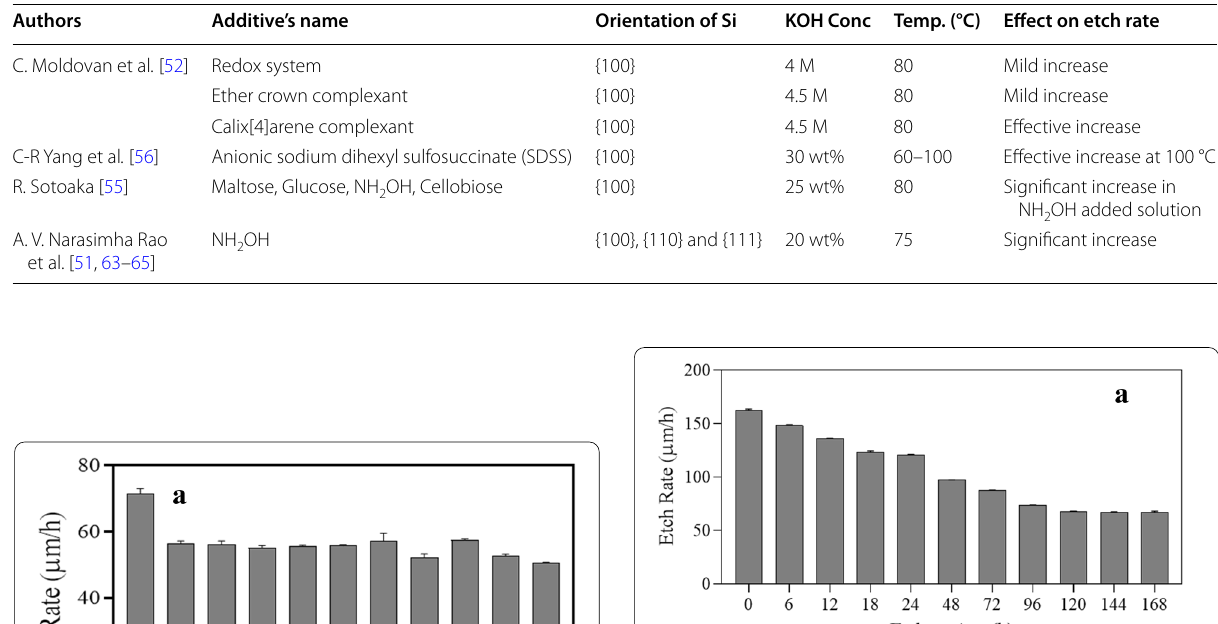
Table 3 The effect of various kinds of additives on the etch rate of silicon in KOH solution